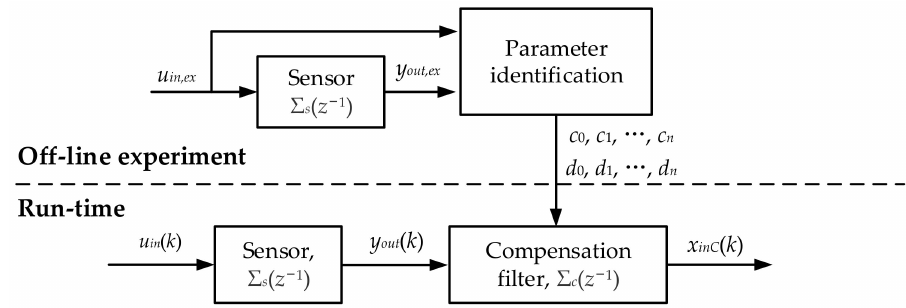
Figure 5. LTI system dynamic compensation